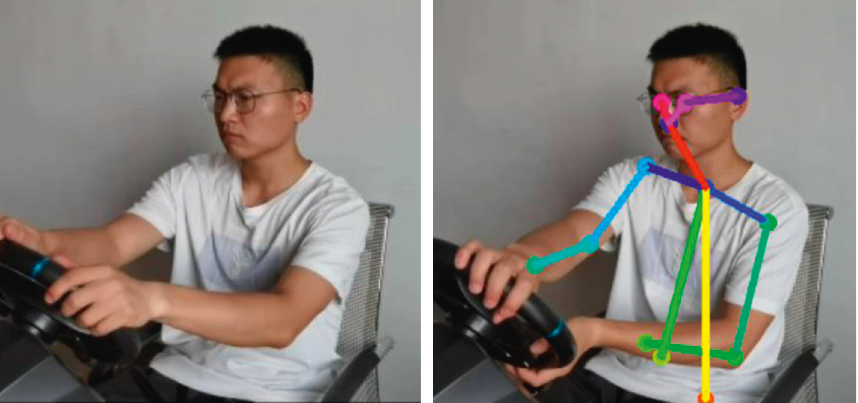
Figure 9: Human body key points location result.